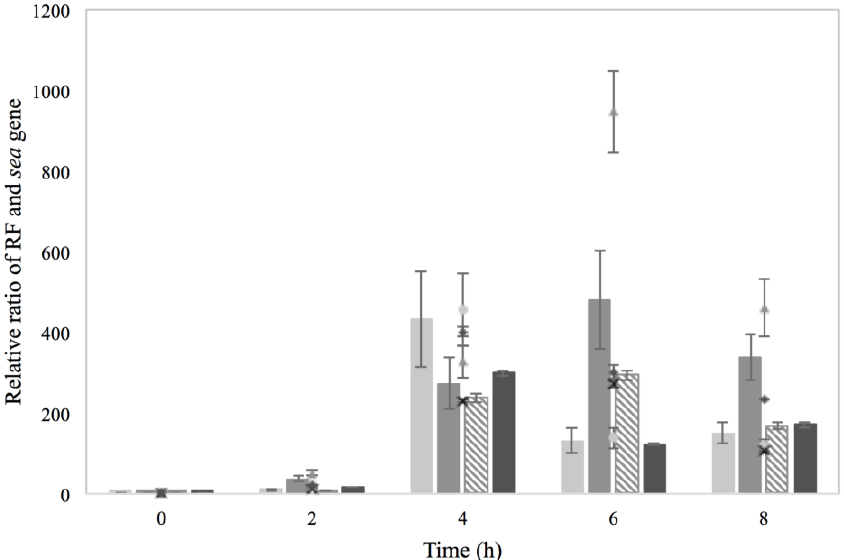
Figure 7. RF (bars) and sea gene (symbols) copies formed in batch cultivation of Sa17 cells under exposure to either NaCl stress or optimal conditions. The cells were pre-grown under optimal or NaCl stress. The Y axis represents the relative ratio levels of RF and sea gene as calculated from Cq values obtained from one independent experiment and the X axis represents the time in h. The investigated treatments are designated: Co–Co with ( ) and (●), Co–Na with ( ) and (▲), Na–Co with ( ) and ( × ) and Na–Na with (■) and (♦).